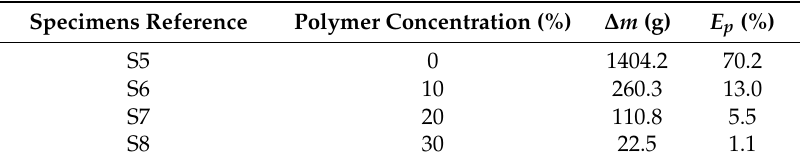
Figure 6. The schematic diagram of water-retaining property: ( a ) Soil; ( b ) soil improved by polymer. Table 2. The rainfall erosion test results.